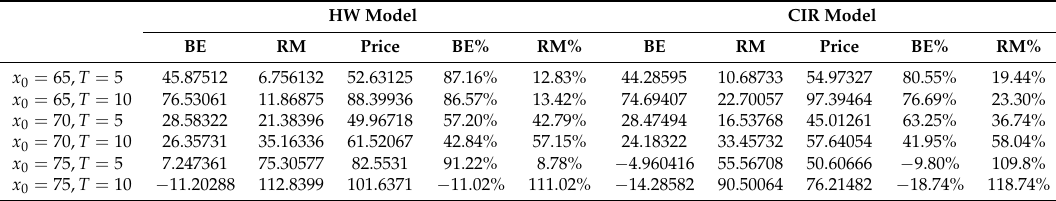
Table 4. Comparison between the prices of the different S-forwards with HW and CIR models.